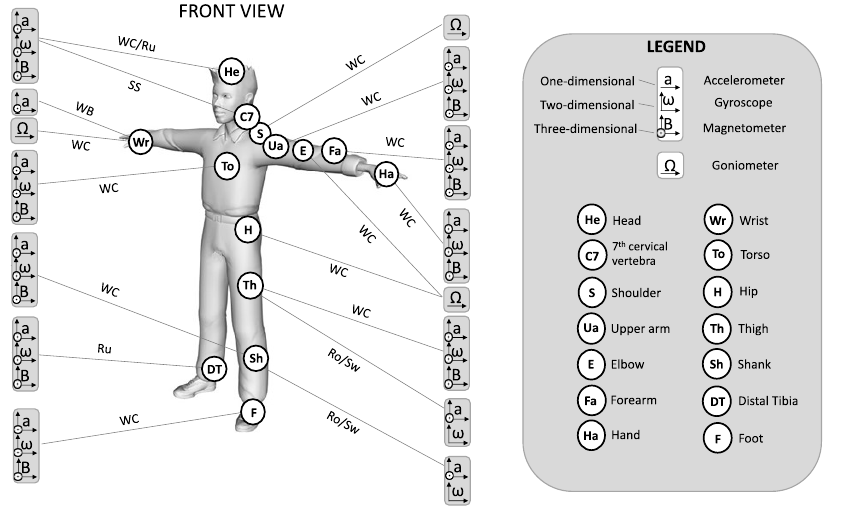
Figure 3. Configuration and positioning of inertial sensors on the athlete’s body. Coding for different body positions, sensor type and number of dimensions is displayed in the legend